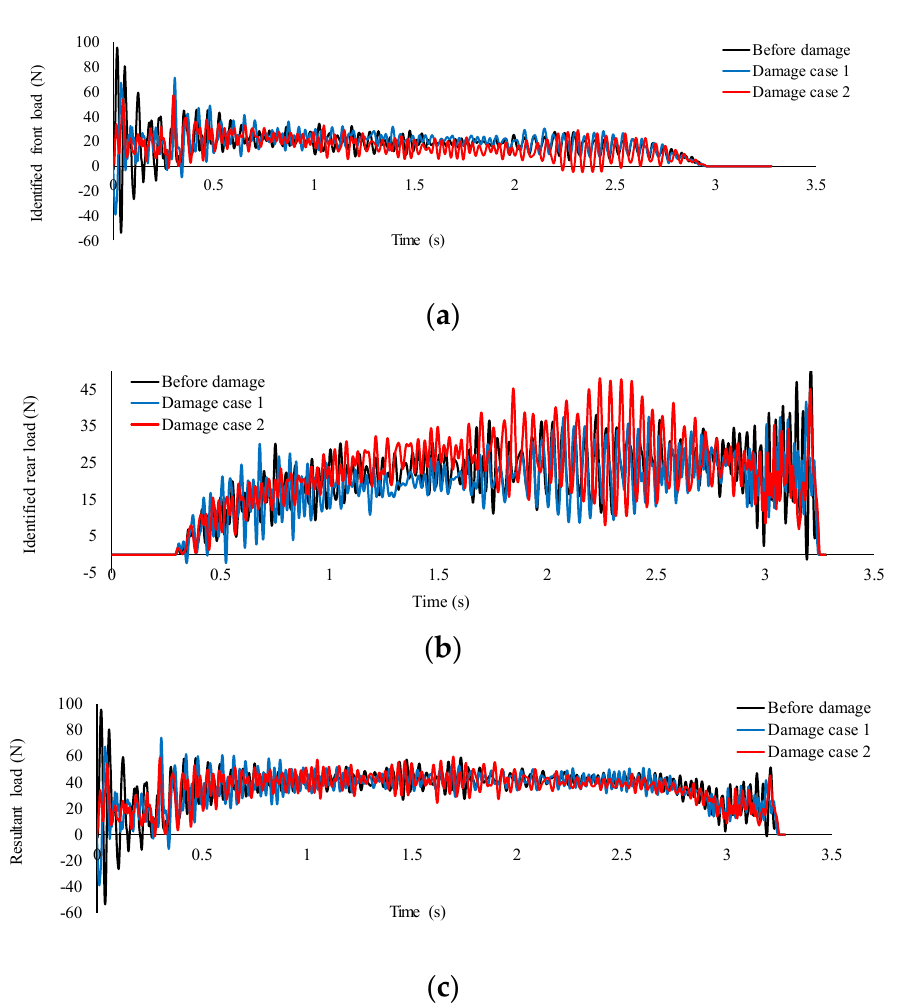
Figure 23. The effect of damage on the identified moving loads at speed of 0.94 m/s (sampling frequency 800 Hz); ( a ) front load; ( b ) rear load; ( c ) resultant